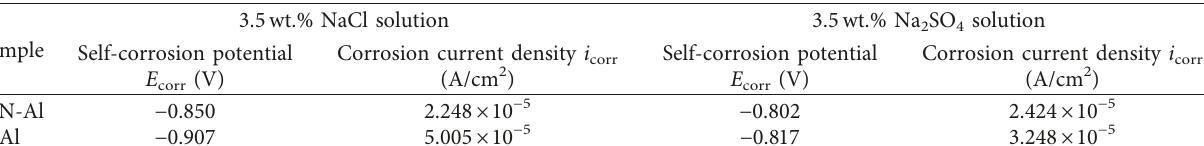
Table 2: The electrochemical parameters of potentiodynamic polarization curves.